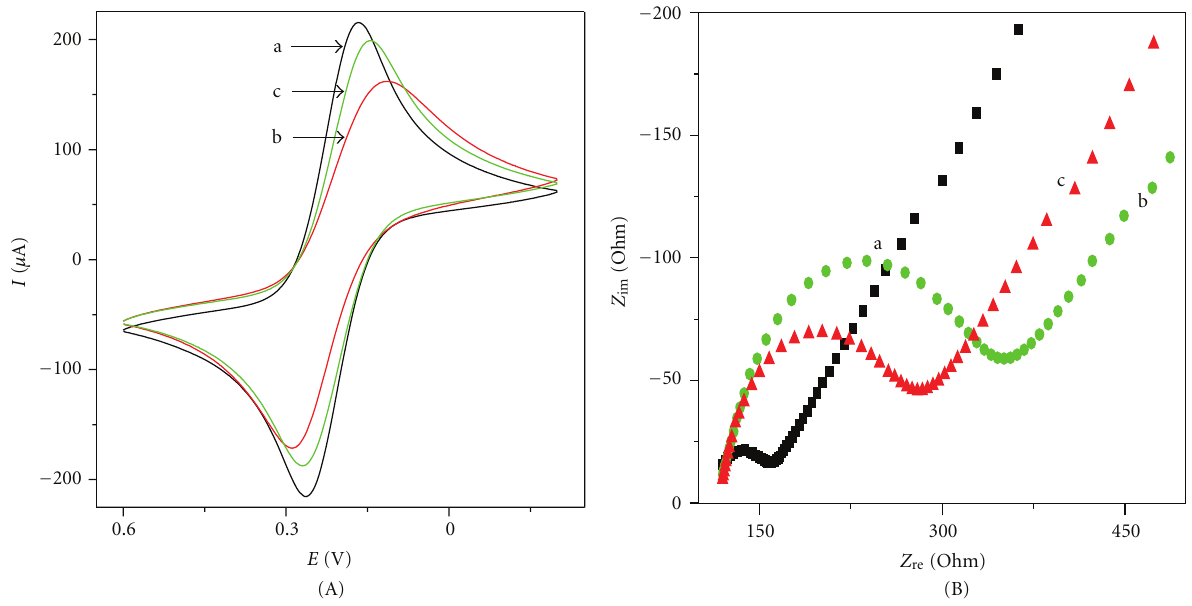
Figure 2: Cyclic voltammograms (A) and electrochemical impedance spectroscopy (B) recorded of the modified electrodes; (a) Bare Au electrode; (b) MPA self-assembled Au electrode; (c) (1R, 2R)-ADE-MPA modified Au electrode. Supporting electrolyte, 5mM [Fe(CN) 6 ] 4 − / 3 − (0.1 M PBS, pH 6.75), 100 mV · s − 1 .